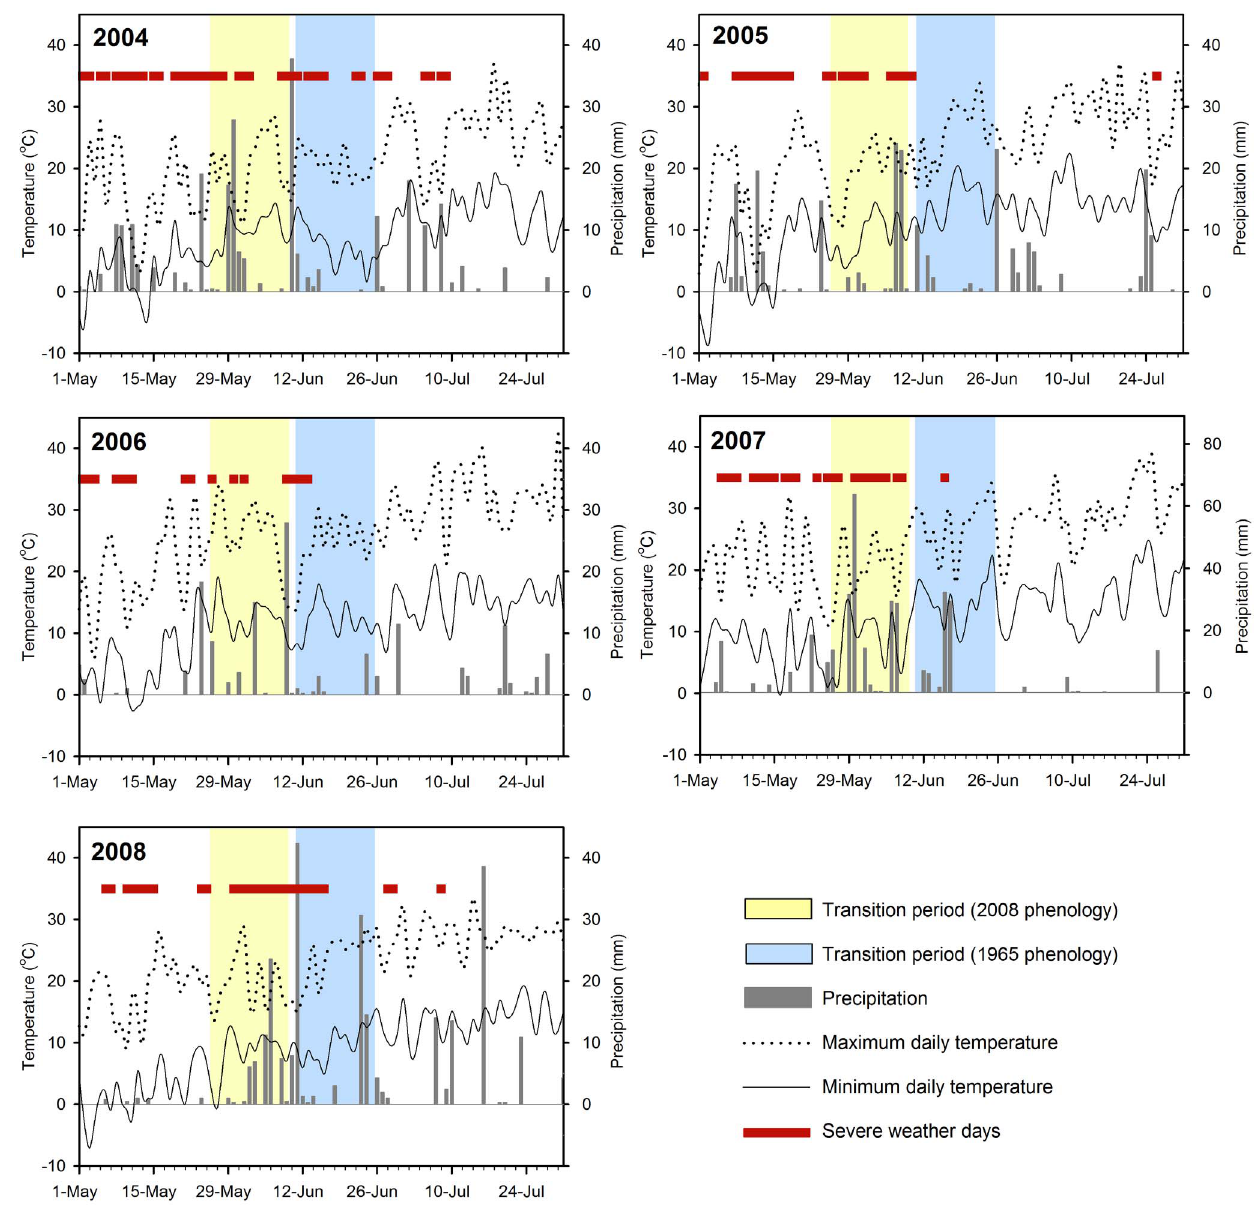
Figure 3. Daily precipitation, maximum and minimum daily temperatures, and severe weather days during May through July in 2004–2008 at Chase Lake, North Dakota. Also indicated are the transition periods (time between chicks being brooded by adults and when chicks become part of a thermally protective cre`che) for both 1965 and 2008 breeding phenologies of American white pelicans. Note scale difference in precipitation